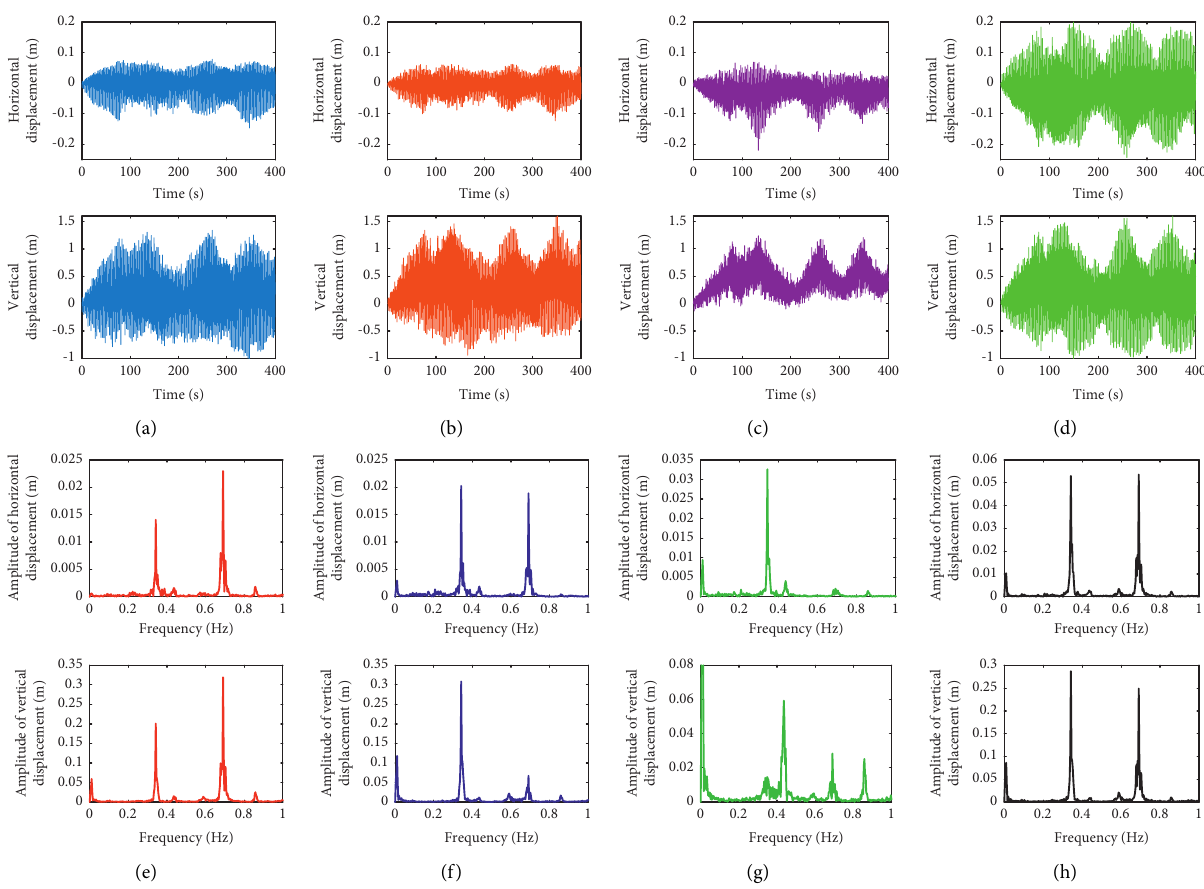
Figure 8: Vibration response under adaptive excitation. (a) Horizontal and vertical displacement time history curves of measuring point 1. (b) Horizontal and vertical displacement time history curves of measuring point 2. (c) Horizontal and vertical displacement time history curves of measuring point 3. (d) Horizontal and vertical displacement time history curves of measuring point 4. (e) Displacement spectrum at measuring point 1. (f) Displacement spectrum at measuring point 2. (g) Displacement spectrum at measuring point 3. (h)